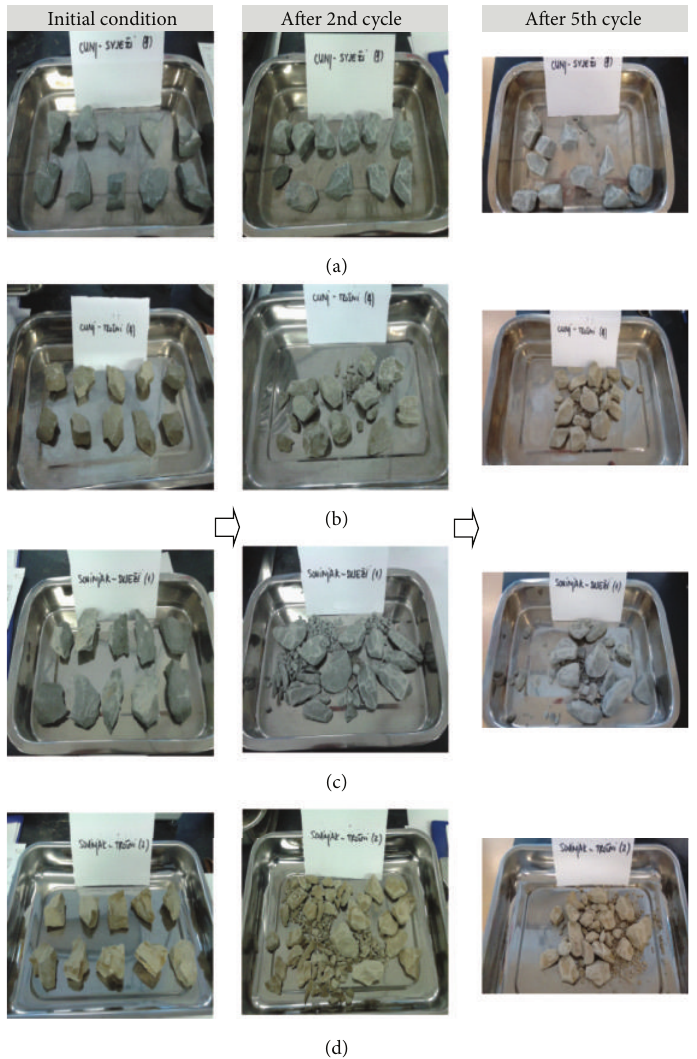
Figure 6: Samples taken from flysch outcrops near ((a), (b)) Cunj Village and ((c), (d)) Sovinjak Village, including initial conditions (left), after the 2nd cycle (middle), and after the 5th cycle (right) of the slake durability